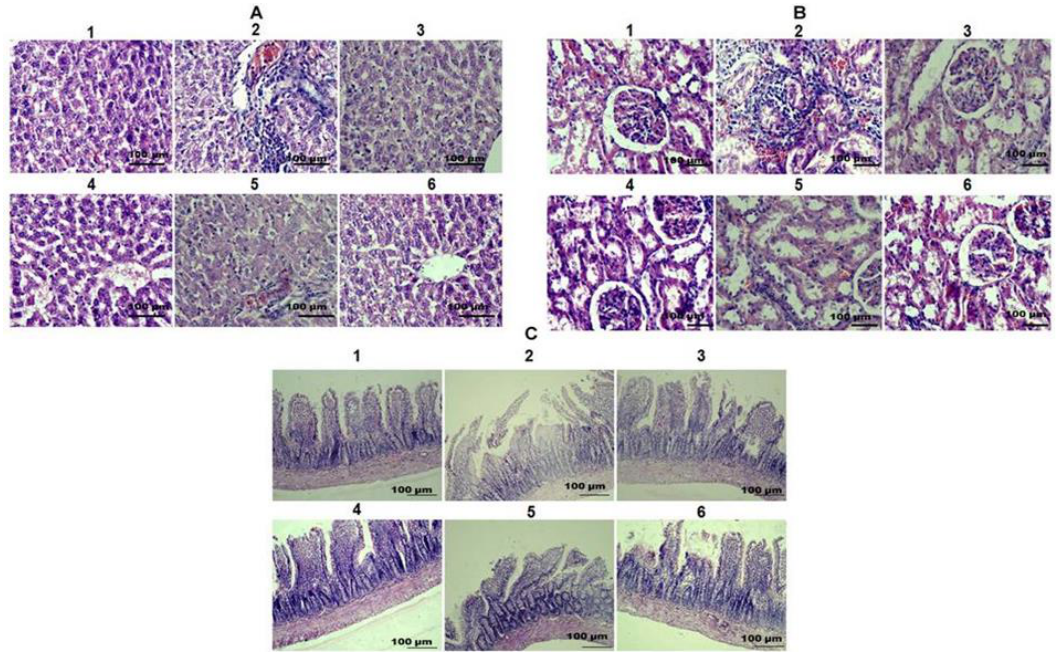
Note: All samples were administered as mg/kg body weight/day. 2.6. TAFEMgO NPs Restore the Liver, Kidney, and Small Intestine Morphology Microscopic examination of the livers, kidneys, and small intestines from the control group (Figure 6(A1,B1,C1)) and the TAFEMgO NPs-alone-treated group (Figure 6(A6,B6,C6)) did not show any abnormality of tissue morphology compared to the positive (silymarin) control-treated group of animals (Figure 6(A3,B3,C3)). However, in the diclofenac-treated rats, massive destruction of liver, kidney, and small intestine tissues was indicated (Figure 6(A2,B2,C2)). Hepatocellular degeneration was observed in liver histology through increased cell infiltration. Tubular degeneration was found in the kidneys. Villi necrosis was noticed in the small intestine section. Interestingly, synthesized nanoparticles restored the structures of the damaged livers, kidneys, and small intestines from diclofenac-induced oxidative stress (Figure 6(A4,A5,B4,B5,C4,C5)) in a dose-dependent manner.